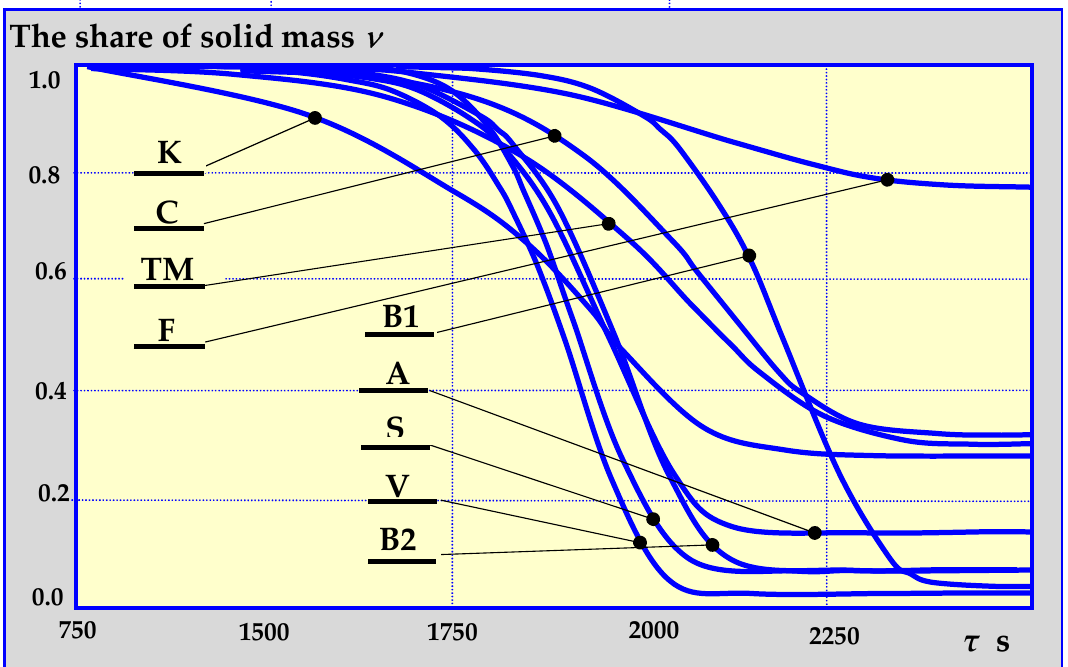
Figure 12. Dependence of biomass loss on the duration of pyrolysis at a constant rate of temperature increase of 10 K / min and the final temperature of 800 K for established mechanisms of